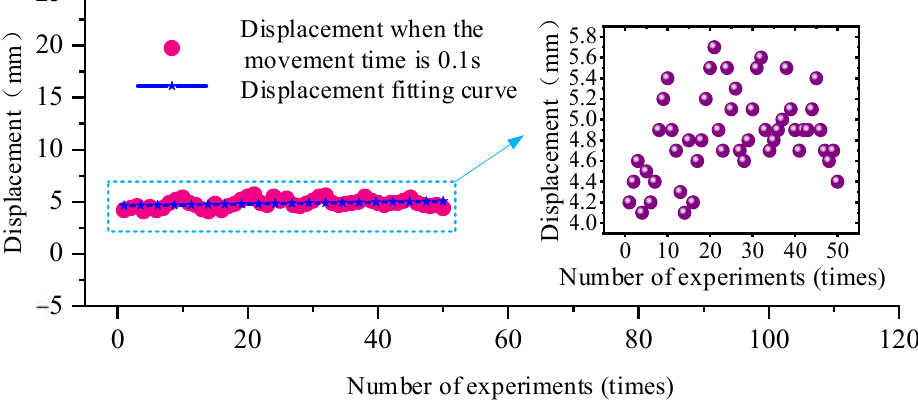
Figure 18. Variation curve of displacement with time during extension movement of the pushing cylinder of hydraulic support.